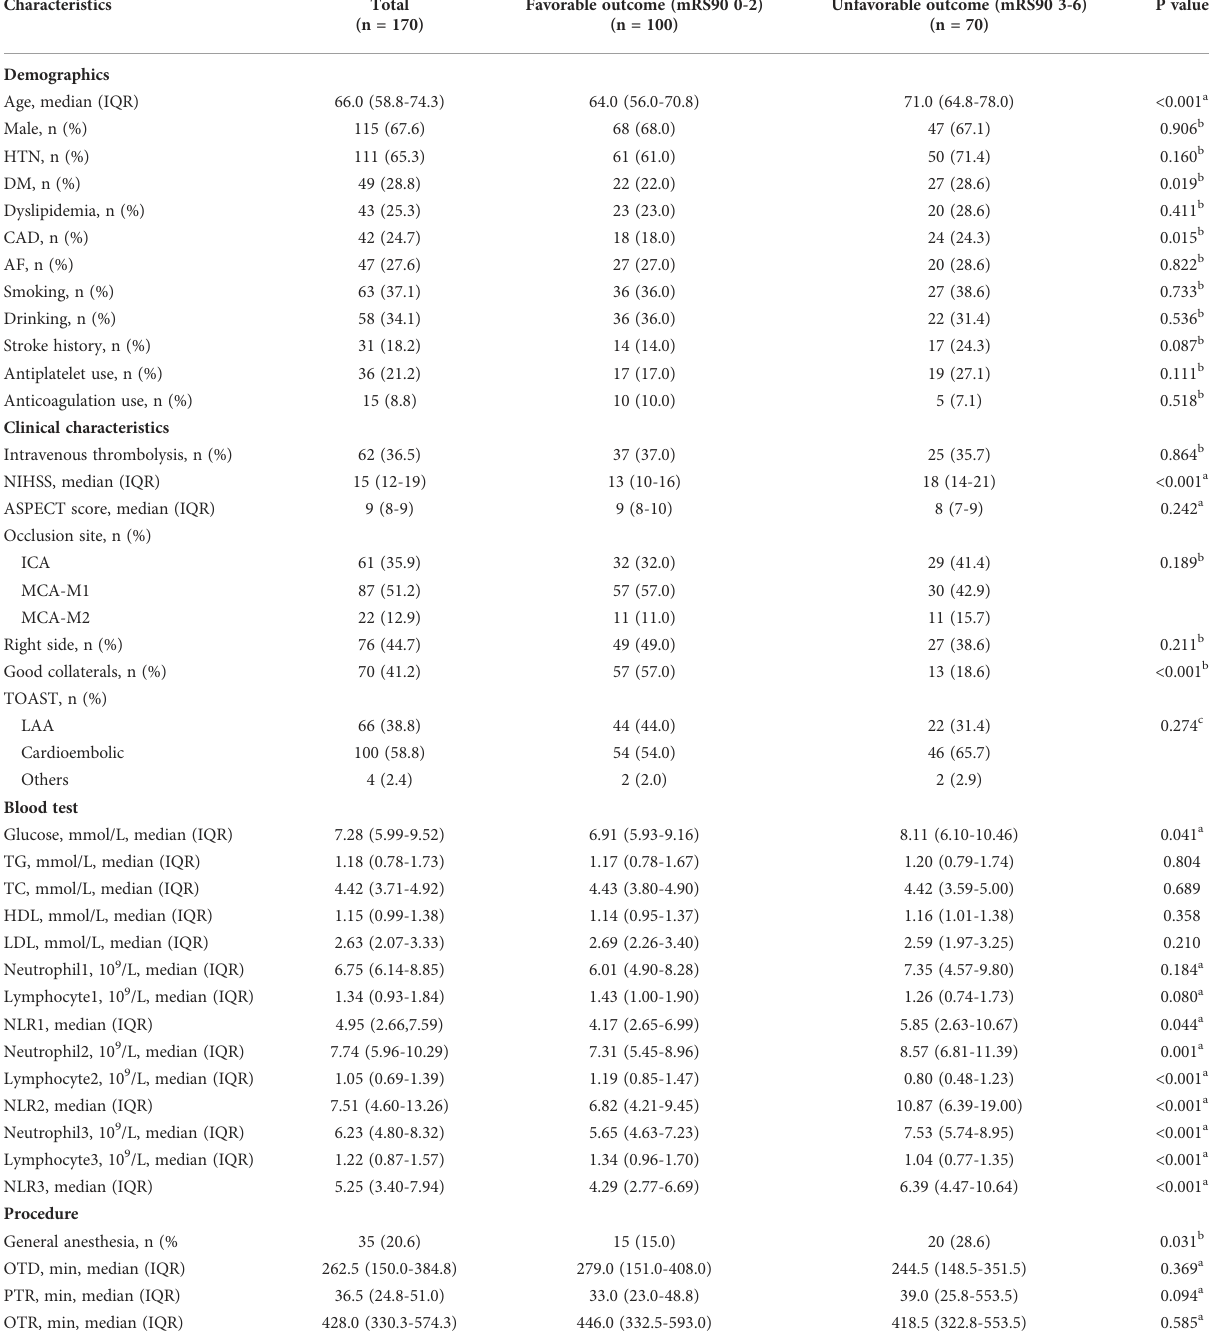
TABLE 1 Patient demographics, clinical characteristics, blood test and procedure information.